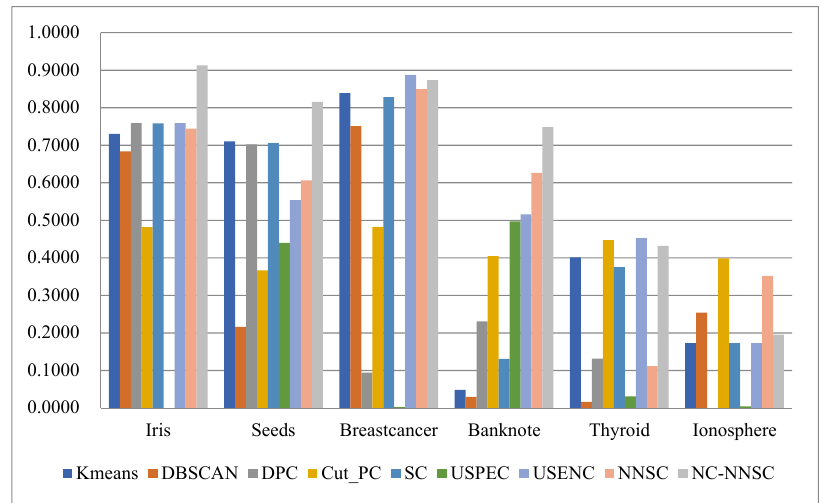
Figure 16. The Adjusted Rand Index (ARI) index of different clustering algorithms in six real-world datasets.